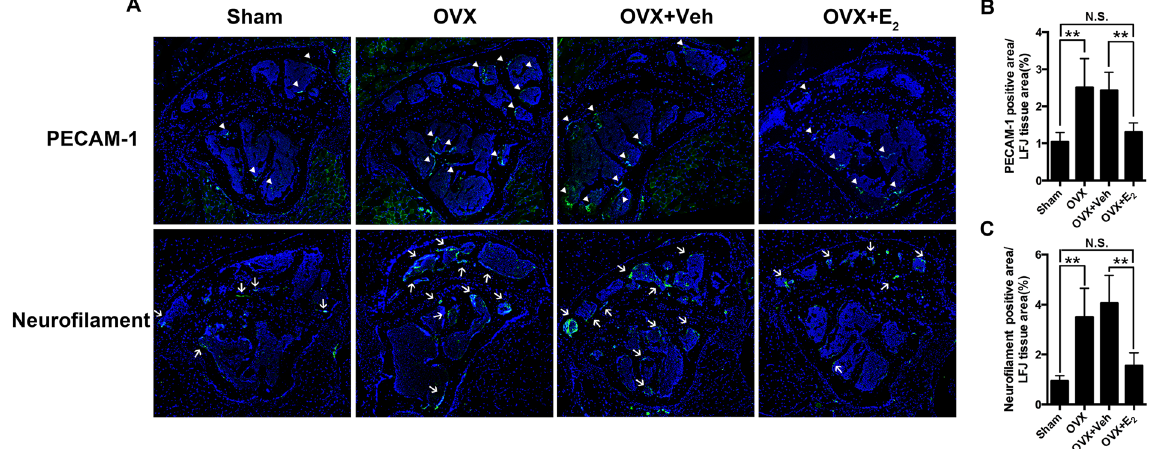
Figure 5. Estrogen deficiency promotes blood vessels and nerve endings innervation into LFJ. ( A ) PECAM-1- positive blood vessels (white arrow head) and neurofilament-positive nerve endings (white arrow) in LFJs from different groups. ( B and C ) Quantitative evaluation of PECAM-1-positive areas and neurofilament-positive areas in LFJ (magnification 600 × ). Key: ** P < 0.05, (N.S.) not